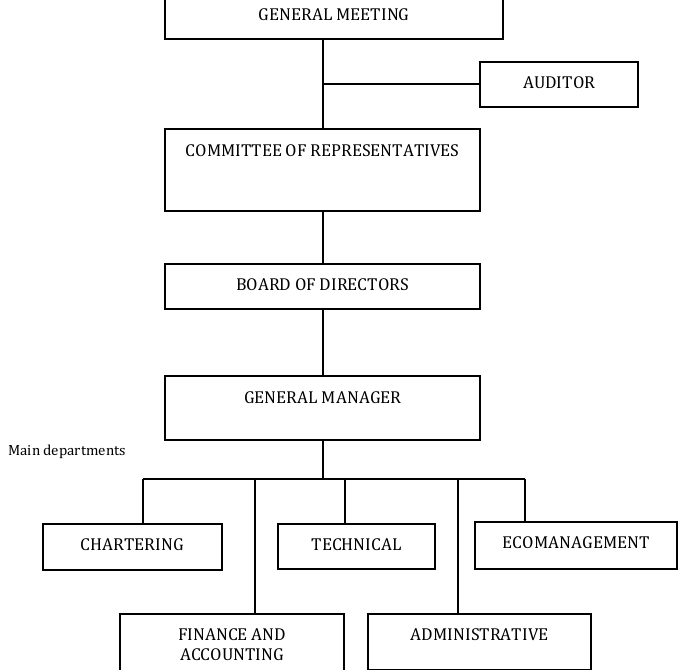
Figure 1. Organizational chart of a shipping company with Ecomanagement